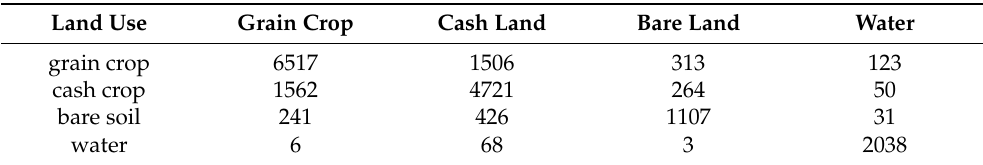
Table 4. Confusion matrix of crop classification obtained from SVM using the GLCM parameter dataset extracted from Landsat 7 time-series dataset in 2010.